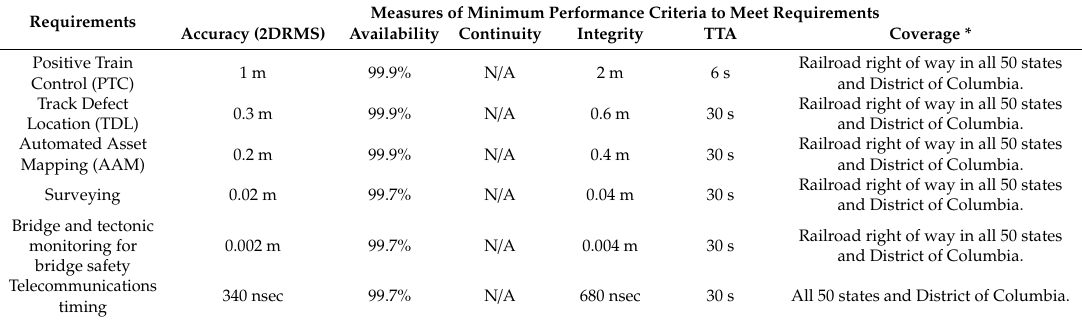
Table 1. Rail user requirements. Own study based on: [59].